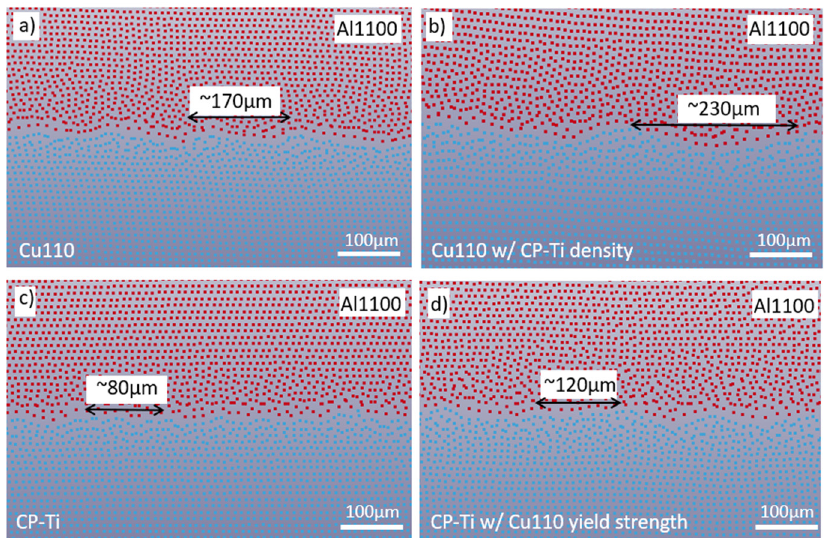
Figure 11. Interface morphologies of Al1100 & ( a ) Cu110, ( b ) fictitious Cu110 with the density of CP-Ti, ( c ) CP-Ti, and ( d ) fictitious CP-Ti with the yield strength of Cu110.